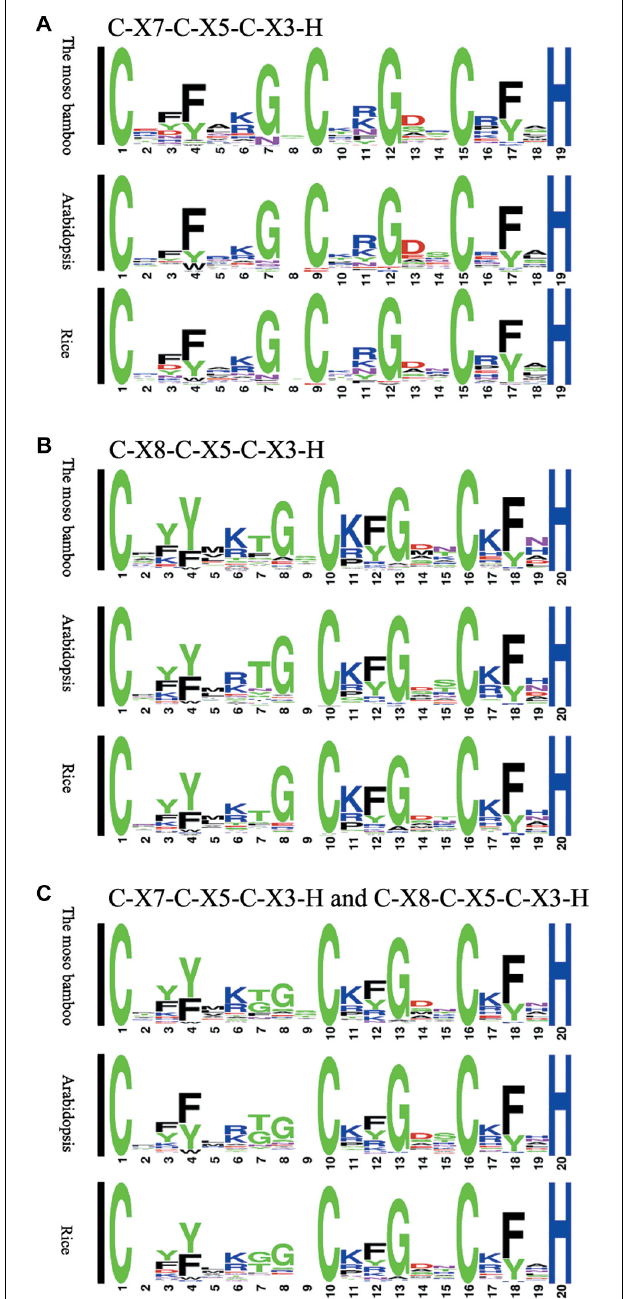
FIGURE 1 | Sequence logos for common CCCH zinc finger motifs. (A) C-X 7 -C-X 5 -C-X 3 -H motifs of moso bamboo, rice and Arabidopsis thaliana . (B) C-X 8 -C-X 5 -C-X 3 -H motifs of moso bamboo, rice and A. thaliana . (C) C-X 7 -C-X 5 -C-X 3 -H and C-X 8 -C-X 5 -C-X 3 -H motifs of moso bamboo, rice and A. thaliana . The conservativeness of amino acids in different positions is indicated by the size of the characters.